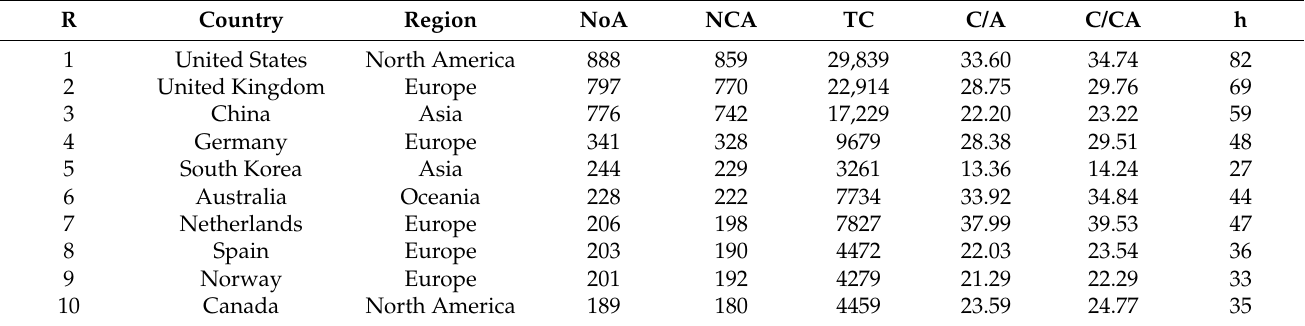
Table 5. The top ten most productive and influential countries.